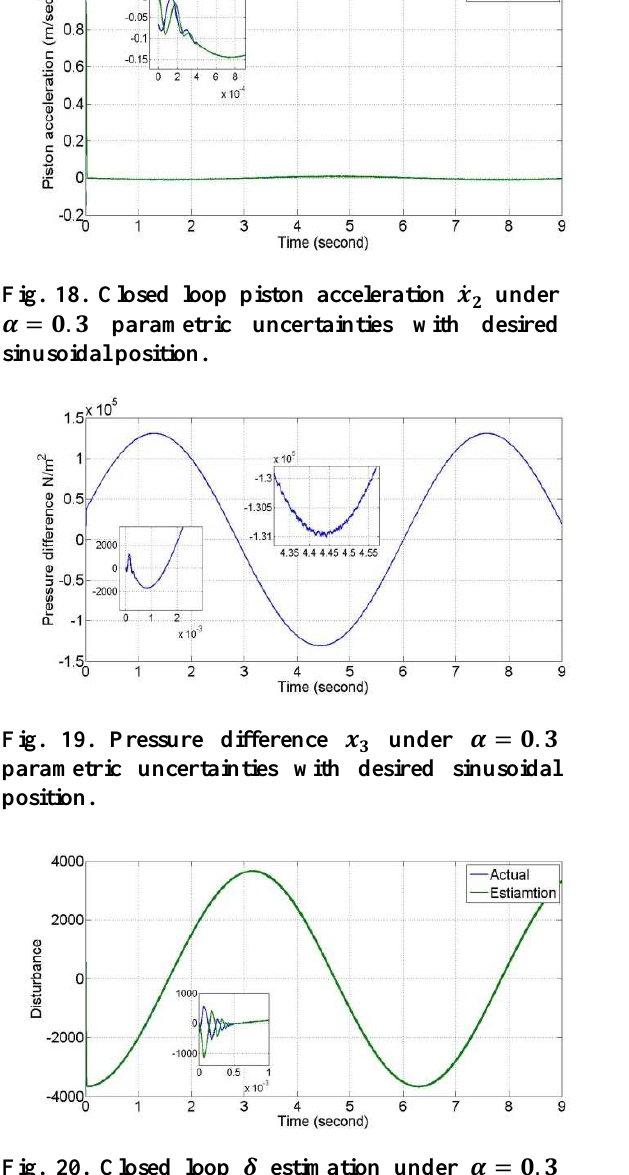
(cid:159) = (cid:160). £